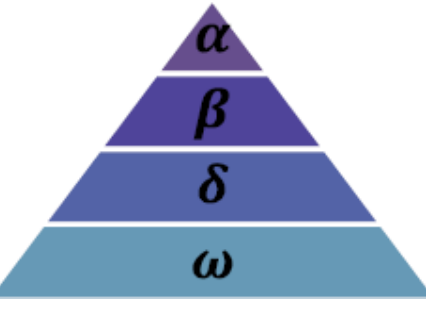
Figure 4. Hierarchies of the gray wolf [27].